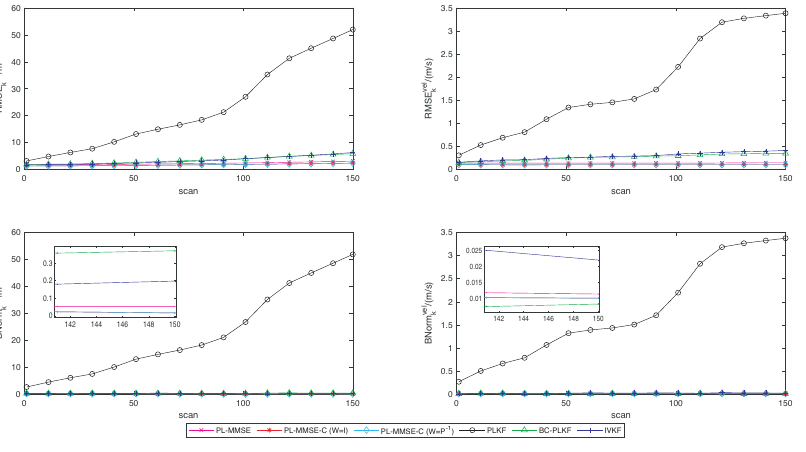
Figure 5. RMSEs, BNorms at different time scan for σ θ = 7 ◦ for the PL-MMSE, PLKF, BC-PLKF and IVKF algorithms, as well as, the proposed PL-MMSE algorithm with linear constraints in the paper. The tracking performance of all algorithms gradually deteriorates with the rising scan under a large bearing noise level. The metric values of PL-MMSE gradually approach RMSE pos k